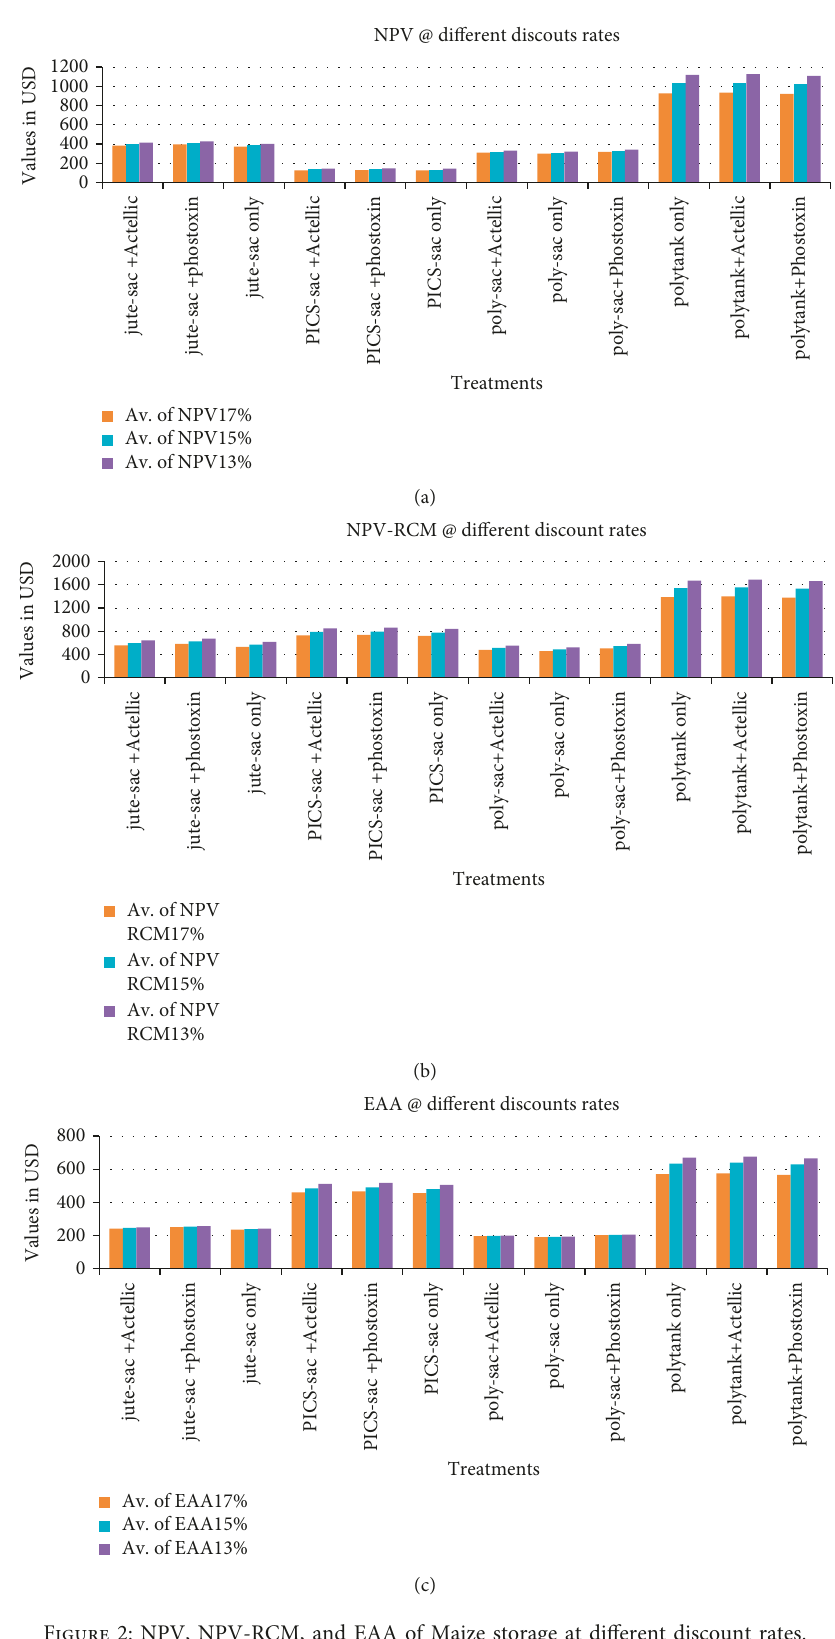
Figure 2: NPV, NPV-RCM, and EAA of Maize storage at different discount